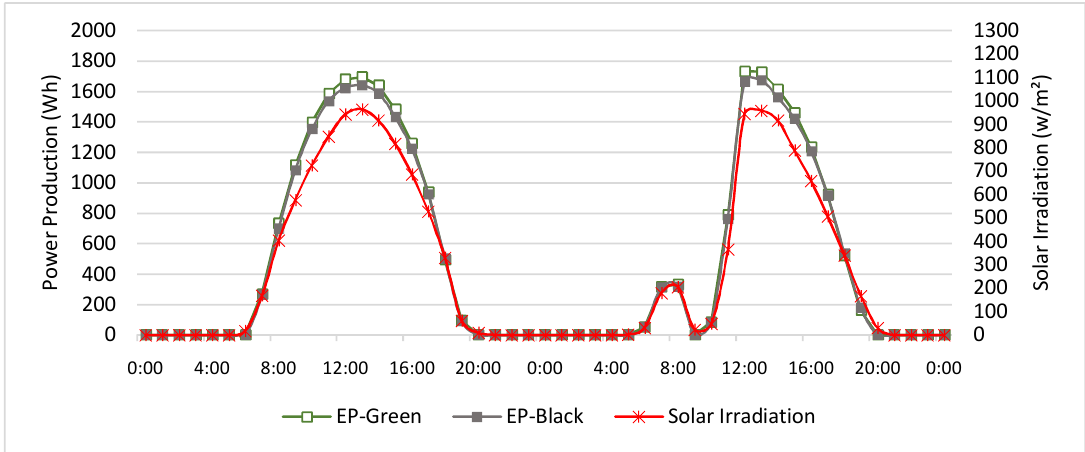
Energies 2018 , 11 , x FOR PEER REVIEW temperature of 46.5 °C. The ambient temperature from the weather station was 37.2 °C. The AT-Green and the AT-Black at the peak were 5.3 °C and 9.3 °C hotter than Station AT, respectively. The underside surface temperature profile shows maximum temperature differences of 4.3 °C at the peak temperature. The UST-Green and UST-Black reached a peak temperature of 62.1 °C and 66.4 °C, respectively. On the second day, the ambient temperature profiles at the peak show a maximum temperature difference of 2.6 °C. The AT-Green reached a peak temperature of 41.5 °C whereas the AT-Black reached a peak temperature of 44 °C and the ambient temperature from the weather station was 34.7 °C. The AT-Green and AT-Black at the peak were 6.8 °C and 9.3 °C hotter than Station AT. The underside surface temperature profile showed a maximum temperature difference of 3.3 °C at the peak temperature. The UST-Green and the UST-Black reached a peak Figure 9. Energy production performance of EP-Green vs. EP-Black (15–16 June). temperature of 63.3 °C and 66.6 °C, as evidenced in the data. The ambient temperature and underside surface temperature comparisons between the AT-Green and AT-Black and between UST-Green and the UST-Black are shown in Figure 10. On the first day, the ambient temperature profiles at the peak show a maximum temperature difference of 4 °C. The AT-Green reached a peak temperature of 42.5 °C while the AT-Black reached a peak